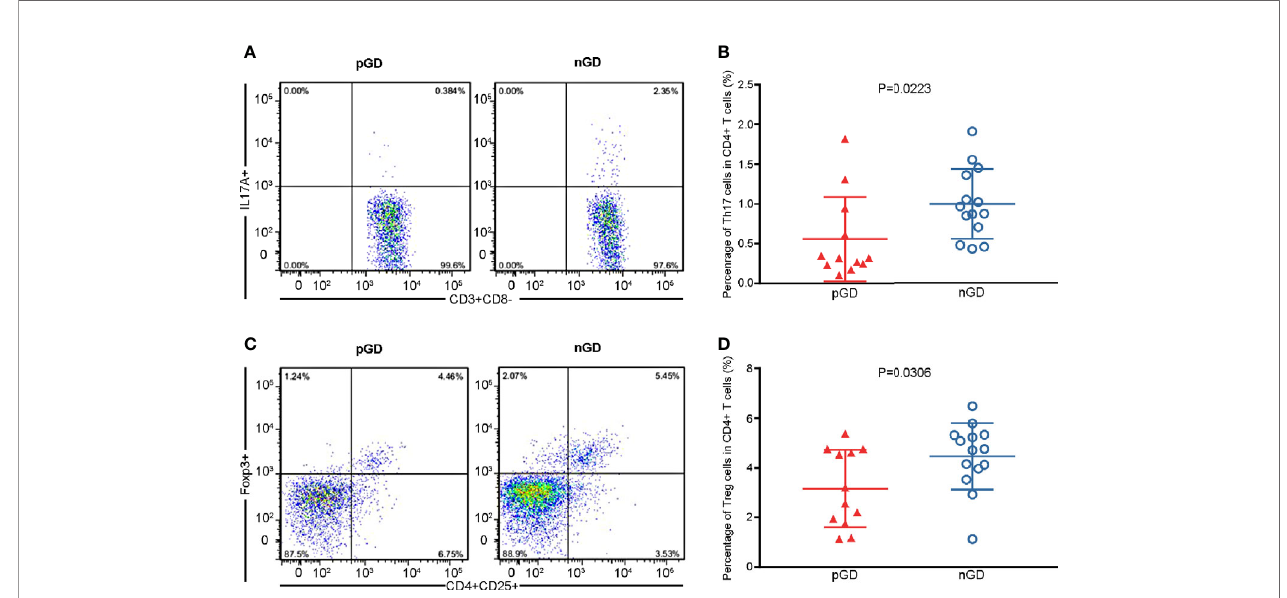
FIGURE 1 | Flow cytometric analysis con fi rmed declined frequencies of Th17 and Treg cells in pGD patients. (A, C) Representative fl ow cytometry plots of (A) Th17 cells (IL17A+) gated in CD3+CD8 − T cells and (C) Treg cells (CD25+Foxp3+) gated in CD4+ T cells from pGD (left) and nGD (right) patients respectively. The numbers denote the percentage of cells in each rectangle gate. (B, D) Whisker plots showed percentage of (B) Th17 cells and (D) Treg cells in CD4+ T cells in pGD (triangle, N = 12) and nGD (circle, N = 14) patients. Data were exhibited as mean with SD with individual values. pGD, persistent Graves ’ disease; nGD, newly diagnosed Graves ’ disease; SD, standard